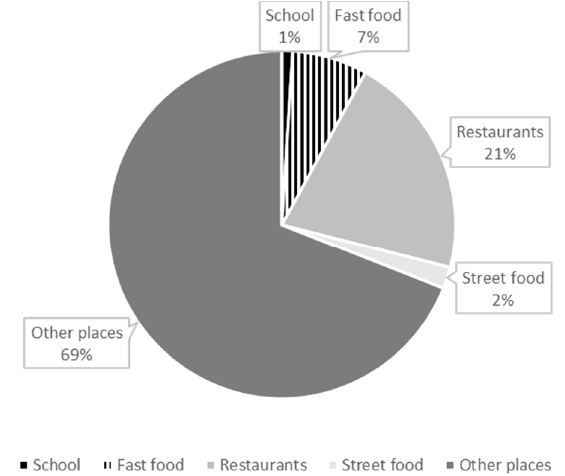
Figure 2. Contribution of place of food consumption to the total carbon footprint from away-from-home food consumption. Brazilian adults in urban areas, 2017–2018 (n = 22,780).